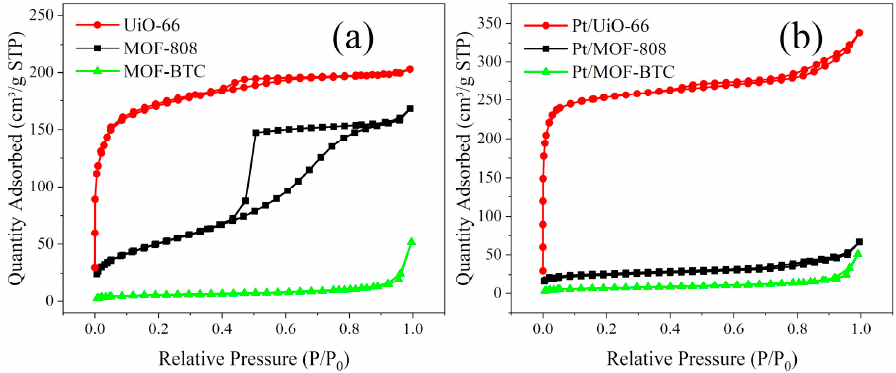
Figure 3. The N 2 adsorption–desorption isotherms of ( a ) Ce–MOF and ( b ) Pt/Ce–MOF. Table 1. BET surface areas, pore volume, percentages of Ce 3+ , Pt 0 , and O ad of all samples.